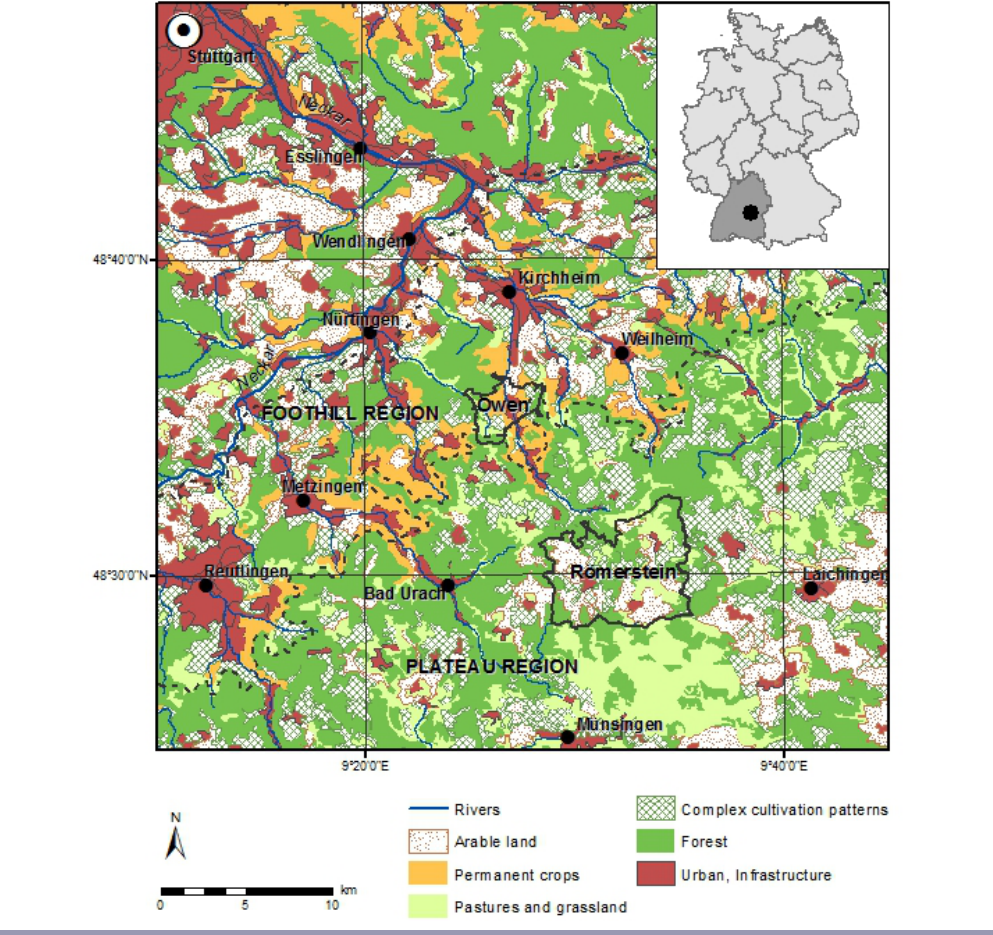
Fig. 1 . Land-cover map and location of the Swabian Alb study area within